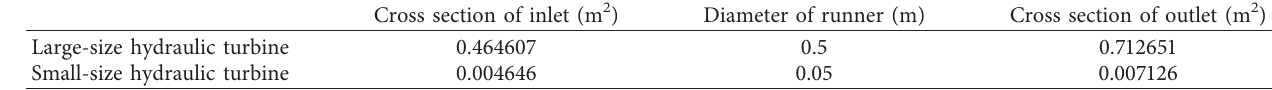
Table 2: Key parameters sizes of hydraulic turbine.